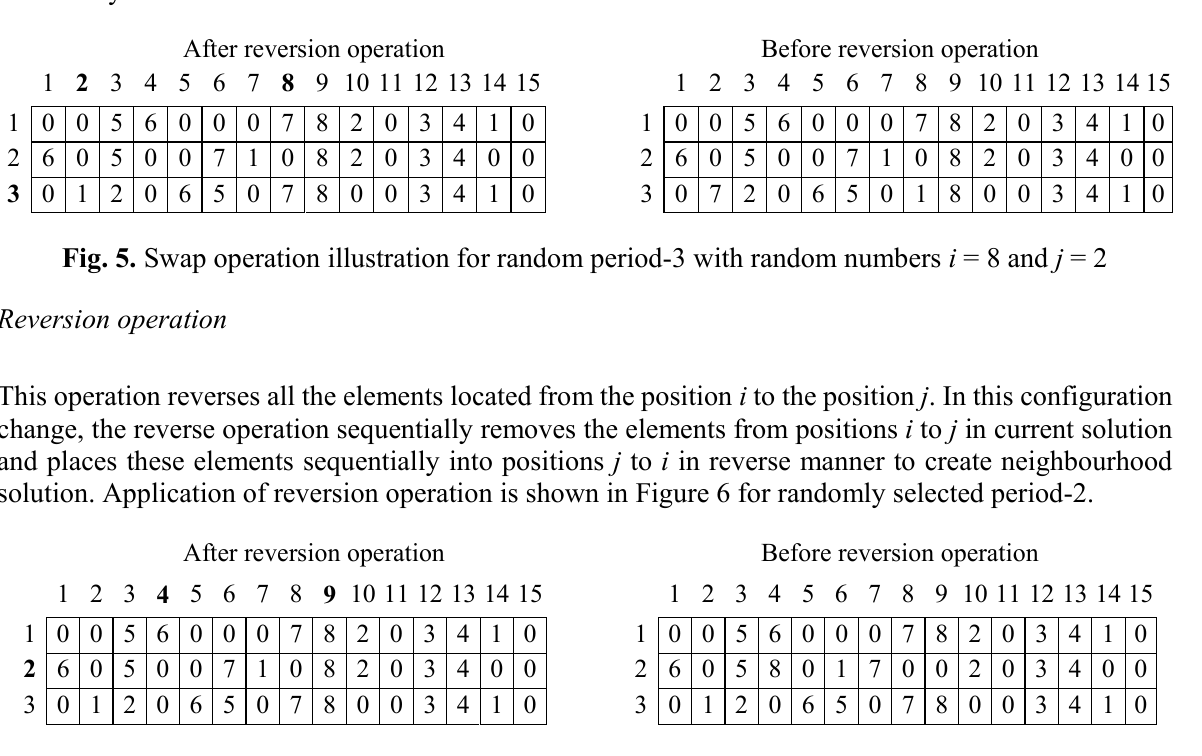
Fig. 6. Reversion operation illustration for random period-2 and random numbers i = 4 and j =